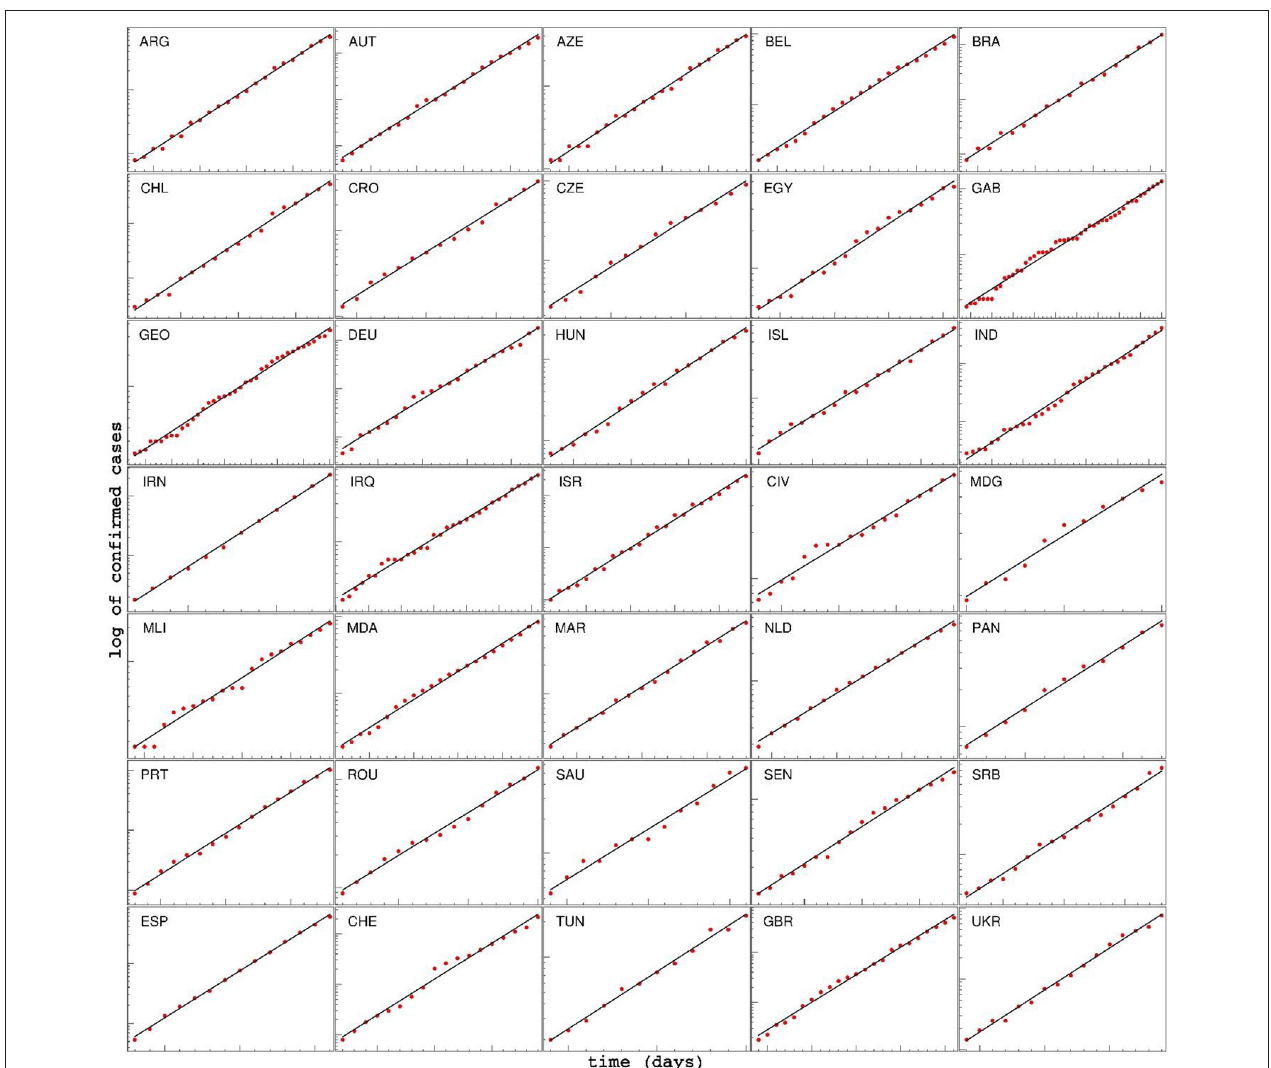
FIGURE 3 | Time dependence of the detected cases for various countries, during the initial period of the epidemic, shown on a log-linear scale. The linear fit of log(D) shows that the spread of COVID-19 in this phase is very well approximated by exponential growth. Note that the values on axes are chosen differently for each country, in order to emphasize the exponential character of the growth. For each country, the start and end dates of the exponential regime, together with the extracted slope λ + , are provided in the Supplementary Table 1 . ARG, Argentine; AUT, Austria; AZE, Azerbaijan; BEL, Belgium; BRA, Brazil; CHL, Chile; CRO, Croatia; CZE, Czech Republic; EGY,Egypt; GAB, Gabon; GEO, Georgia; DEU, Germany; HUN, Hungary; ISL, Iceland; IND, India; IRN, Iran; IRQ, Iraq; ISR, Israel; CIV, Cote d’Ivoire; MDG, Madagascar; MLI, Mali; MDA, Moldova; MAR, Morocco; NLD, Netherlands; PAN, Panama; PRT, Portugal; ROU, Romania; SAU, Saudi Arabia; SEN, Senegal; SRB, Serbia; ESP, Spain; CHE, Switzerland; TUN, Tunis; GBR, Great Britain; UKR,